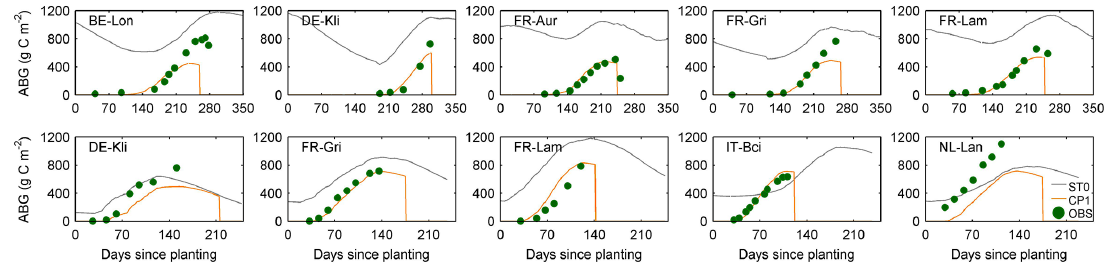
Figure 4. Comparisons of the observed (green dots) and modeled daily aboveground biomass from ORCHIDEE-CROP (ORC-CP1, orange line) and ORCHIDEE (ORC-ST0, grey line) for winter wheat and maize in different sites. The upper and lower panel shows the results for different sites of winter wheat and maize, respectively.